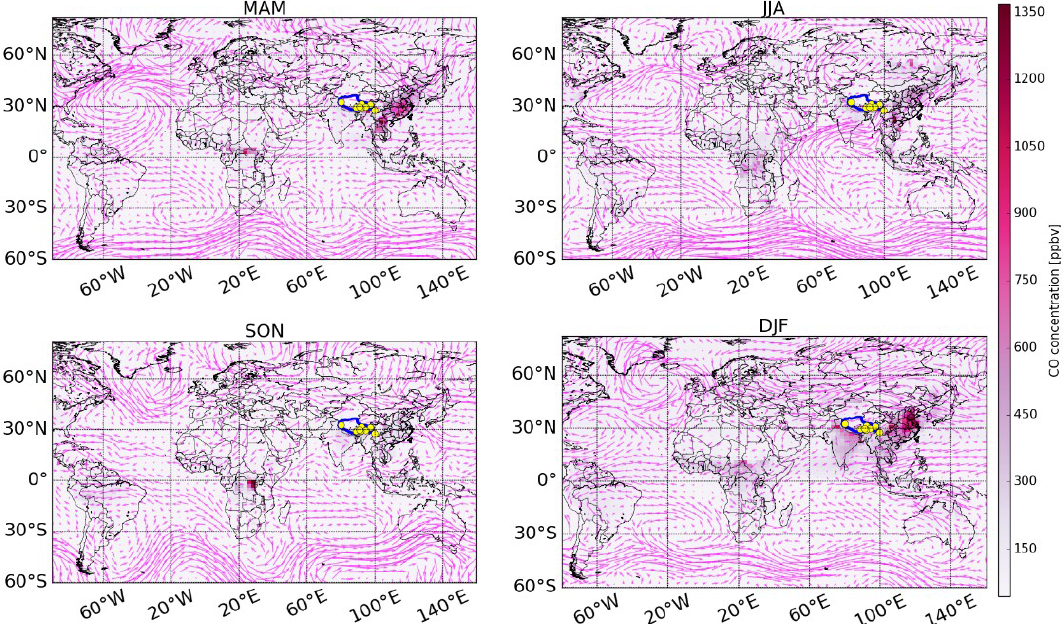
Figure 12. Spatial distribution of CO VMR in the GEOS-Chem tagged CO simulations in different seasons, and the arrows represent the mean horizontal wind vectors at 500hPa. The HTP and the studied regions are marked with a blue outline and yellow dots, respectively. Meteorological fields are from the GDAS-1